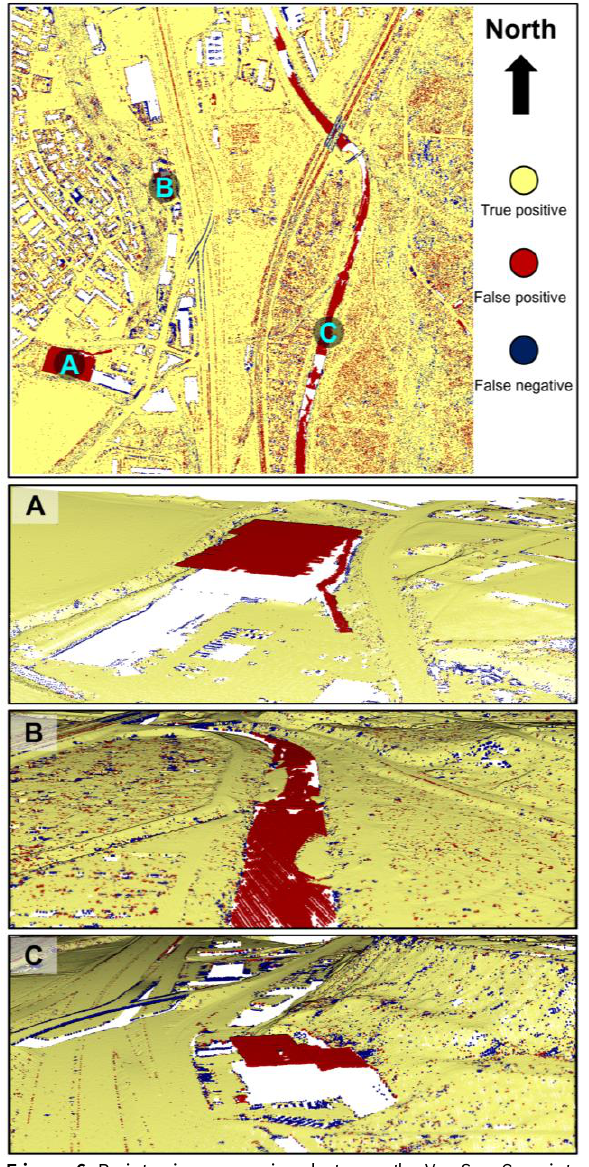
Figure 6 . Point-wise comparison between the Vo-SmoG points and the reference points.